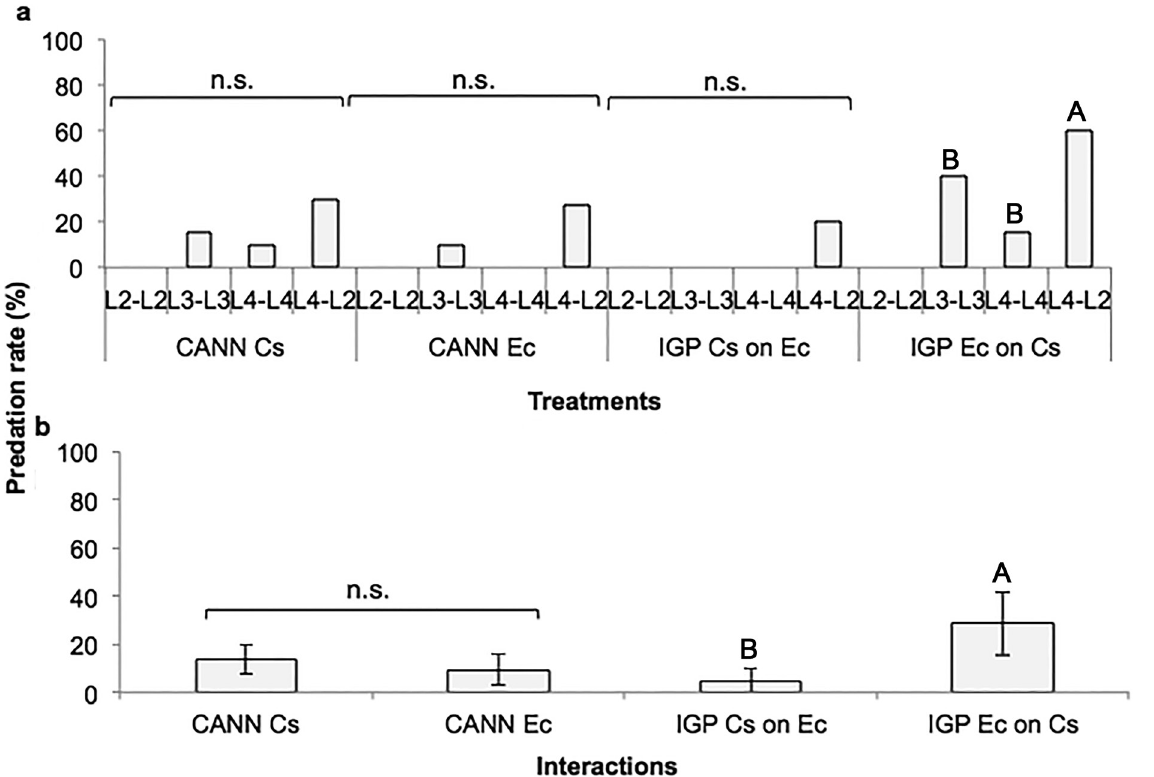
Figure 3. Occurrences of predation between different combinations of larval instars (Panel a ) and mean rates of predation (Panel b ) by conspecific or heterospecific larvae of Cycloneda sanguinea (Cs) and Eriopis connexa (Ec) during 90 min of interaction, in the absence of extraguild prey. CANN, cannibalism; IGP, intraguild predation; L2, second-instar larvae; L3, third-instar larvae; L4, fourth-instar larvae. Different letters indicate significant differences. The brackets denote ± standard error. Different letters indicate significant differences ( P